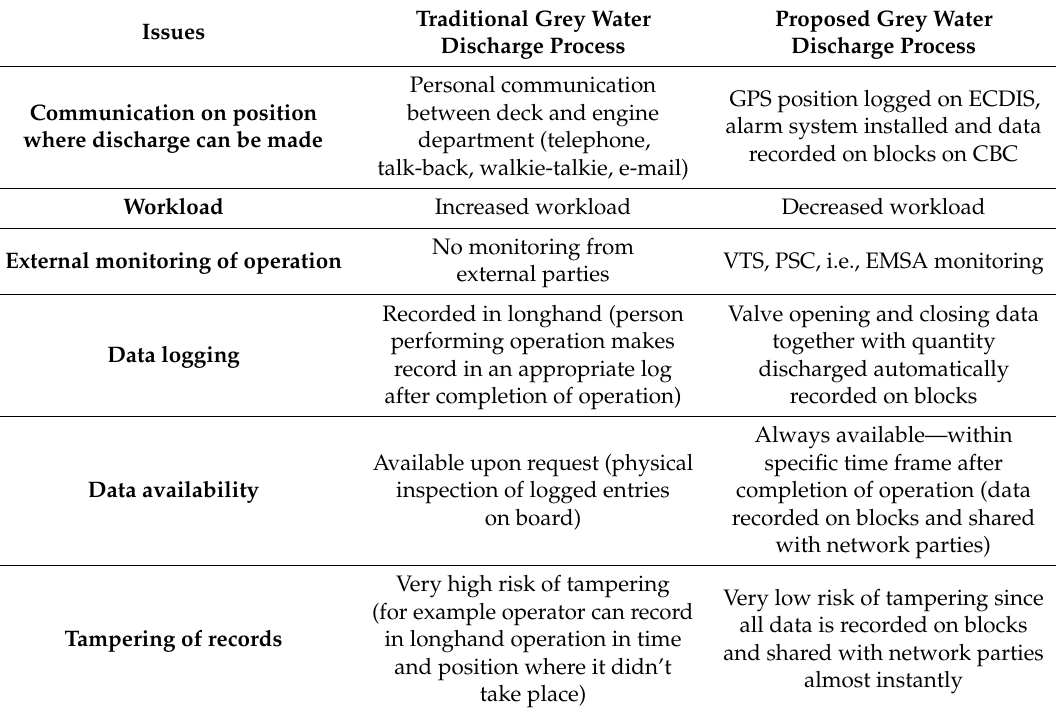
Table 2. Comparison between traditional and proposed grey water discharge process. Source: authors.